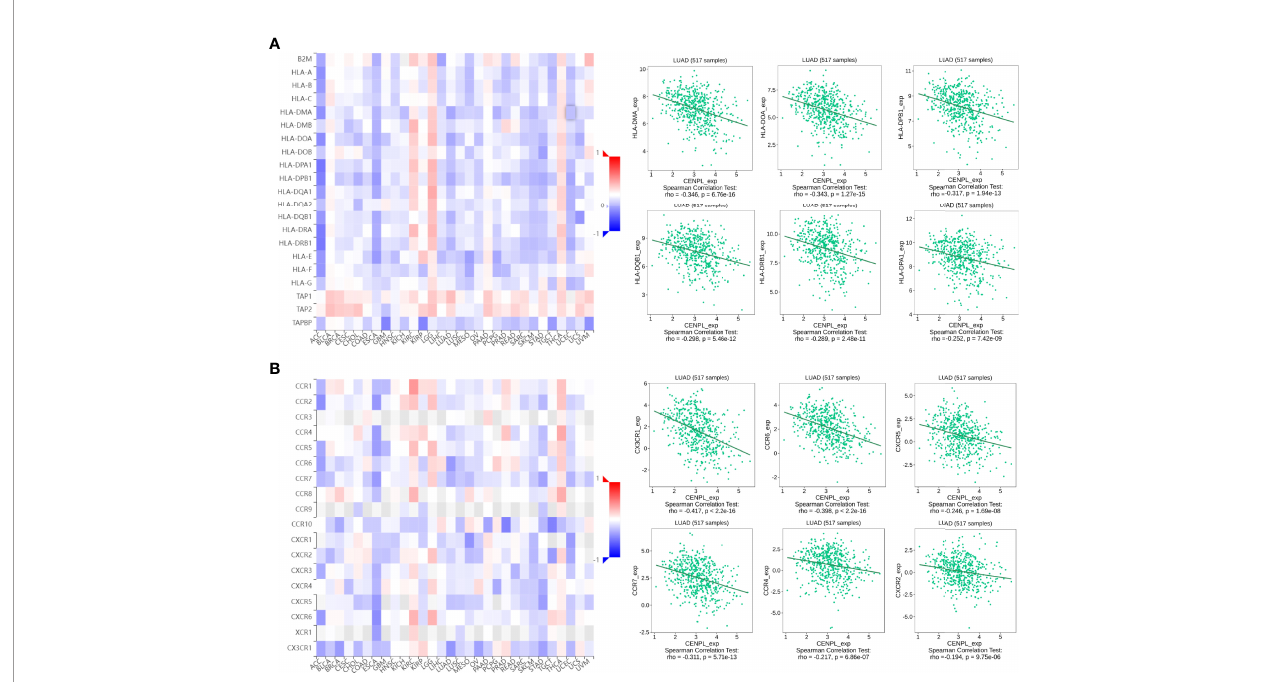
FIGURE 6 | The correlation between CENPL expression and major histocompatibility complexes (MHCs) and chemokine receptors in the TISIDB database. (A) The expression of CENPL is negatively associated with most MHCs in pan-cancer. (B) The expression of CENPL is negatively associated with most chemokine receptors in